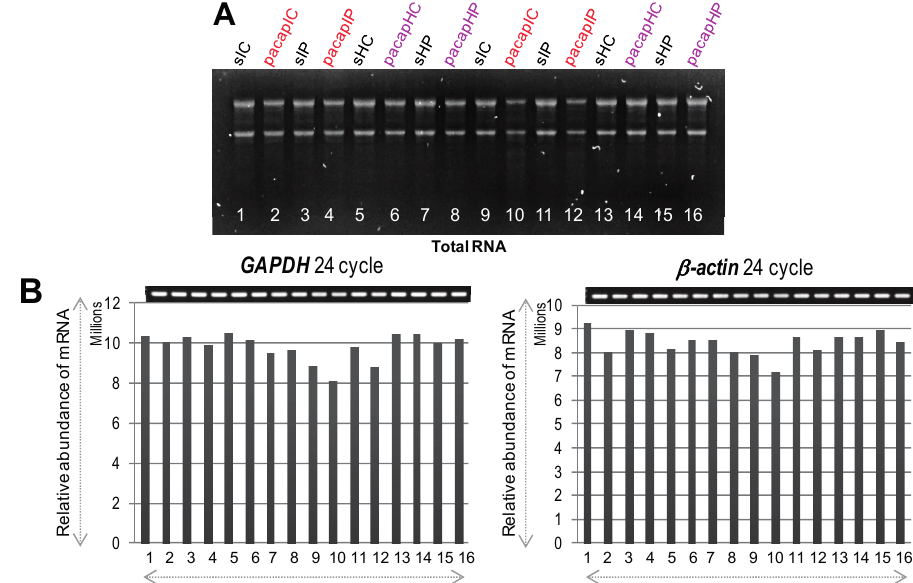
Samples of tissues and treatments as in A